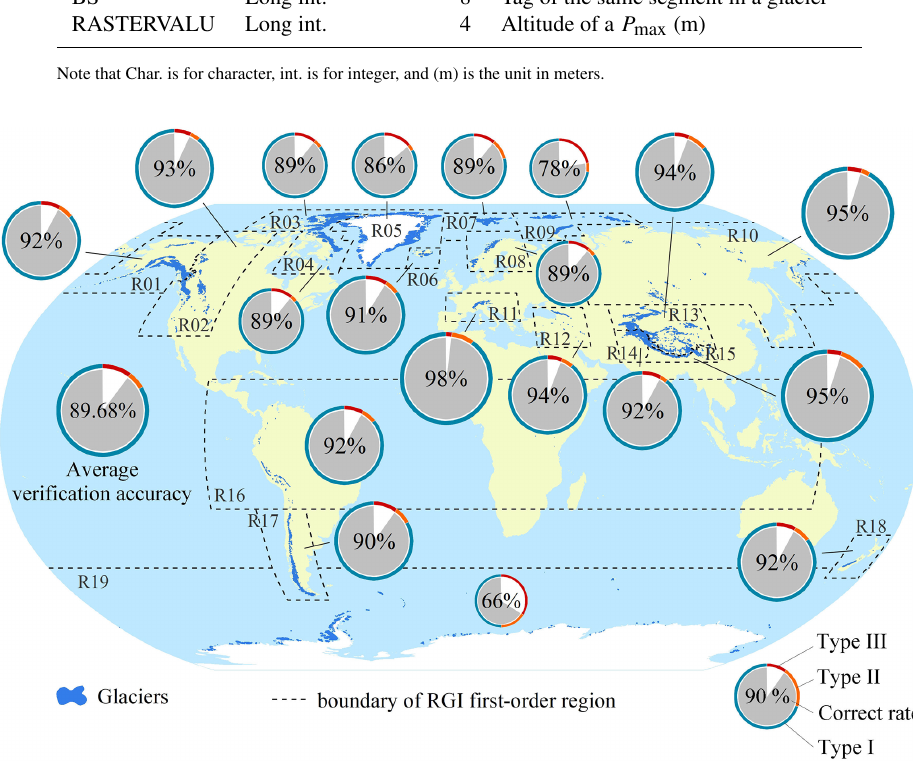
Figure 5. Statistical chart of random evaluation results. The pie charts show the proportion of each type with the total number of samples in the region. The pie charts show the correct rate, which is the proportion of types I and II in each region. The size of the pie chart represents the grade of the correct rate in the region. Types I, II, and III (see Sect. 3.2.4) are correct, inaccurate, and incorrect centerlines,